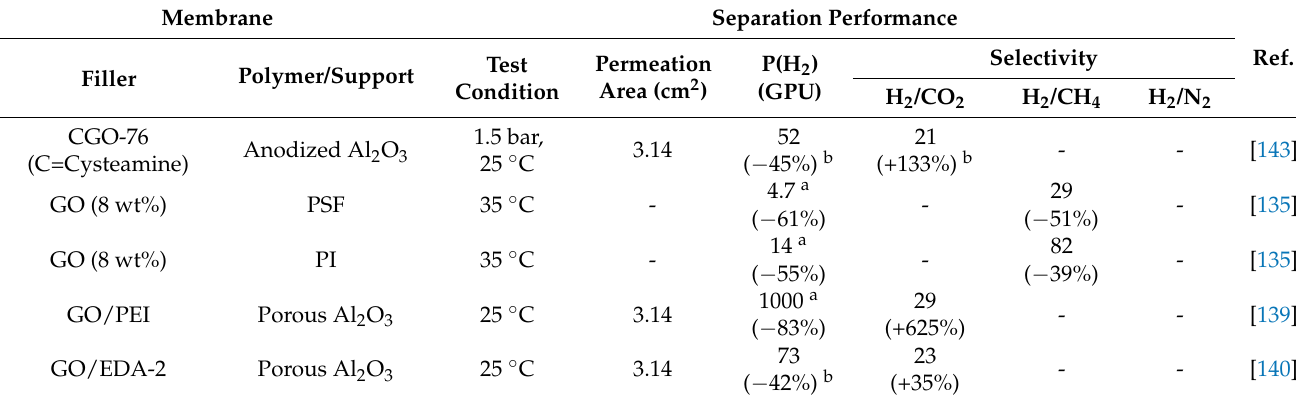
Table 5. Summary of representative performances for graphene-based membranes in H 2 -based separation. Membrane Separation